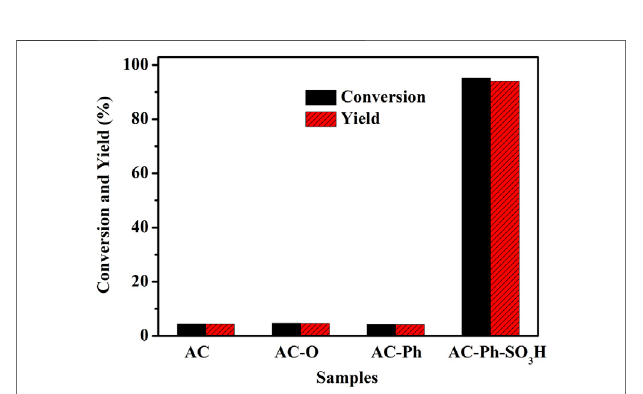
FIGURE 7 | Effect of reaction conditions on methylation of palmitic acid.